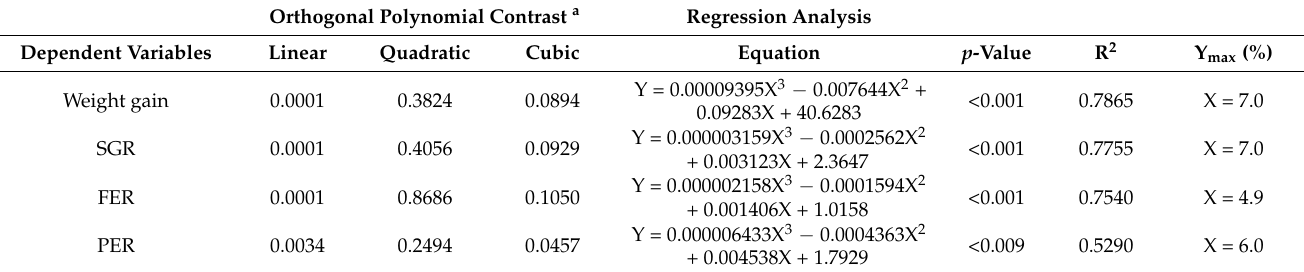
Table 3. Regression analysis of dietary substitution level of fish meal with meat meal as independent variable vs. parameters (weight gain, specific growth rate (SGR), feed efficiency ratio (FER), and protein efficiency ratio (PER) of olive flounder) as dependent